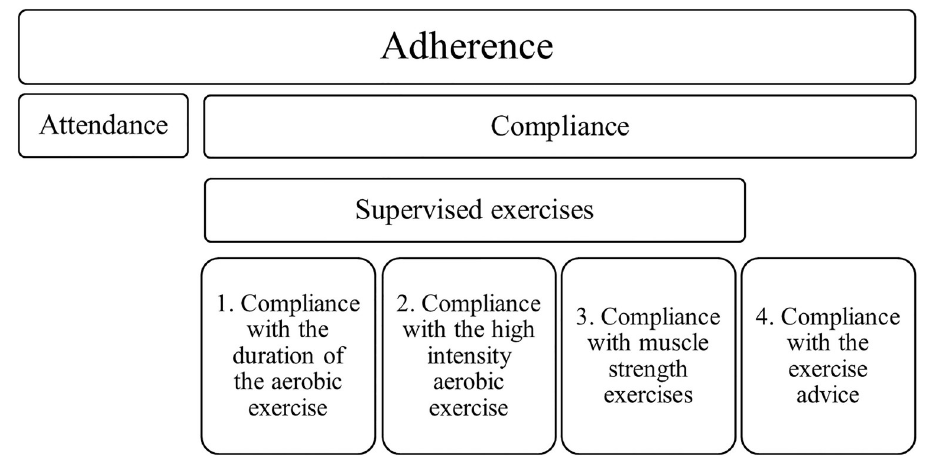
Fig 2. Overview of the outcome measures for